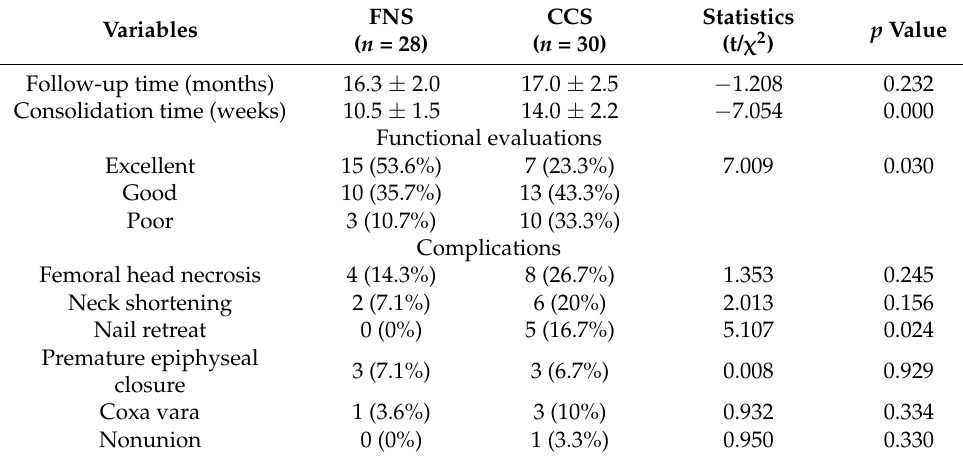
Figure 4. 12-year-old girl with left FNF treated by 3 CCS. ( a ) Postoperative radiograph; ( b ) outcome at 12 months postoperation (AVN and narrowing joint space). Table 3. Comparison of clinical effects and complications.